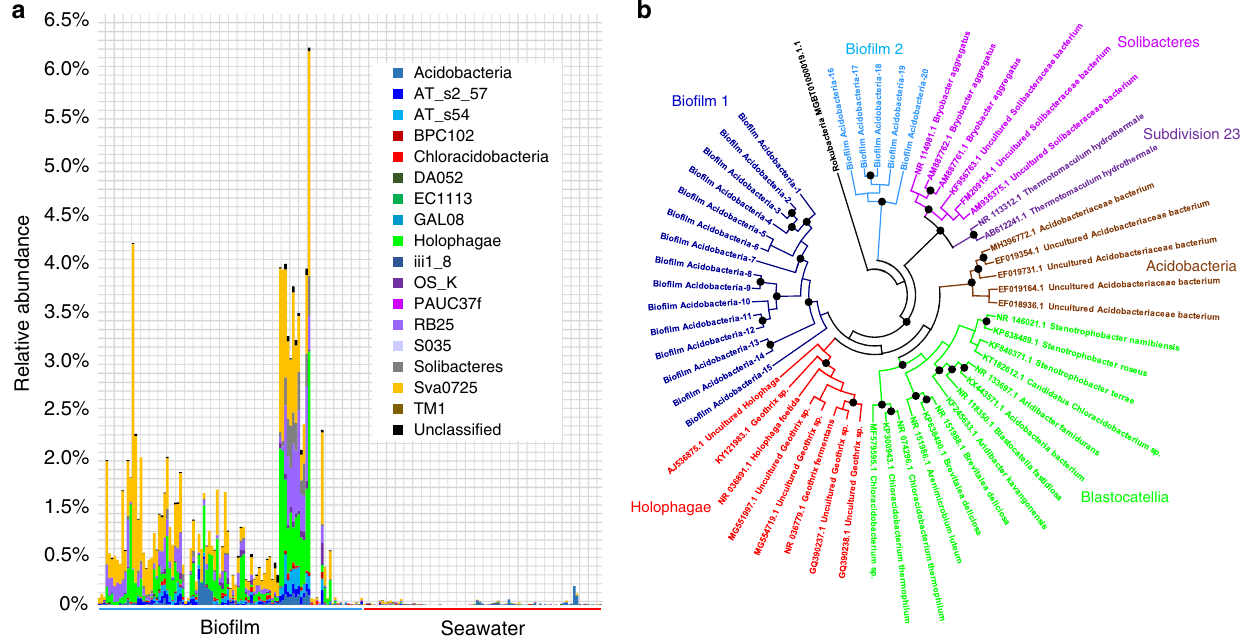
Fig. 5 Novel Acidobacteria lineages. a Distribution of Acidobacteria classes in the bio fi lms and seawater. Based on 16S miTags, several rarely studied or unclassi fi ed groups are enriched in bio fi lms. b Phylogenetic analysis of Acidobacteria 16S rRNA gene sequences (over 1000 bp) extracted from assembled bio fi lm metagenomes. 16S rRNA gene sequences that are available for known Acidobacteria classes were downloaded from the NCBI database and used as references and Rokubacteria was used to root the tree. Black dots indicate bootstrap values above 60. These analyses provide further support for novel microbial lineages within ocean bio fi